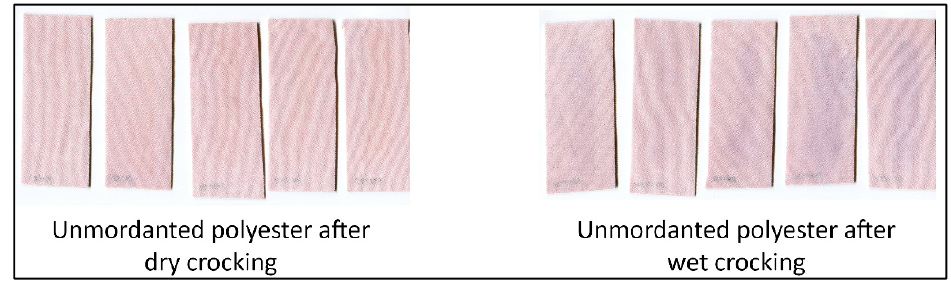
Figure 7. Unmordanted polyester dyed with draconin red shown after dry and wet crocking.